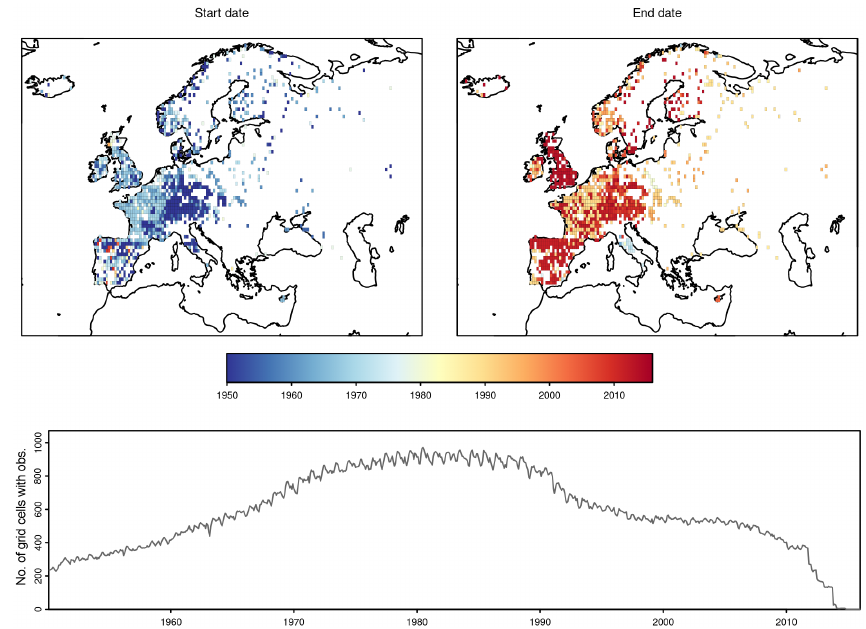
Figure 7. Spatial and temporal coverage after assigning the monthly runoff series to the 0.5 ◦ × 0.5 ◦ defined by the E-OBS data. The top row shows the date of the first and the date of the last available observation at each station. The bottom panel shows the total number of stations with observations for each month.